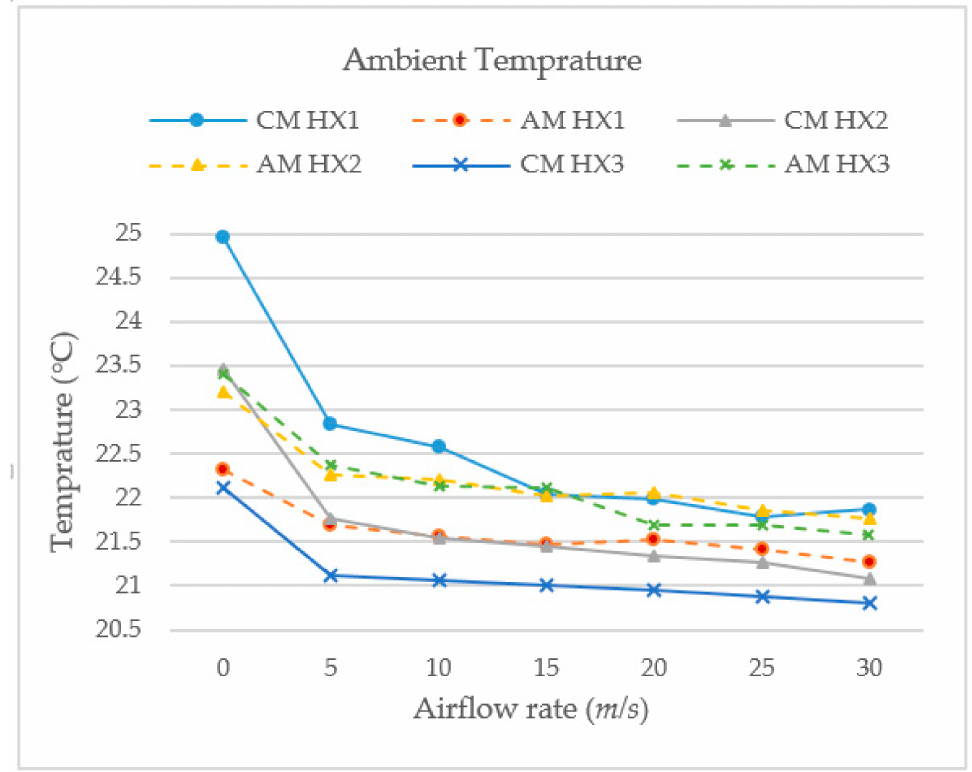
Figure 7. HX ambient temperature for different HXs when the heater temperature was 50 ◦